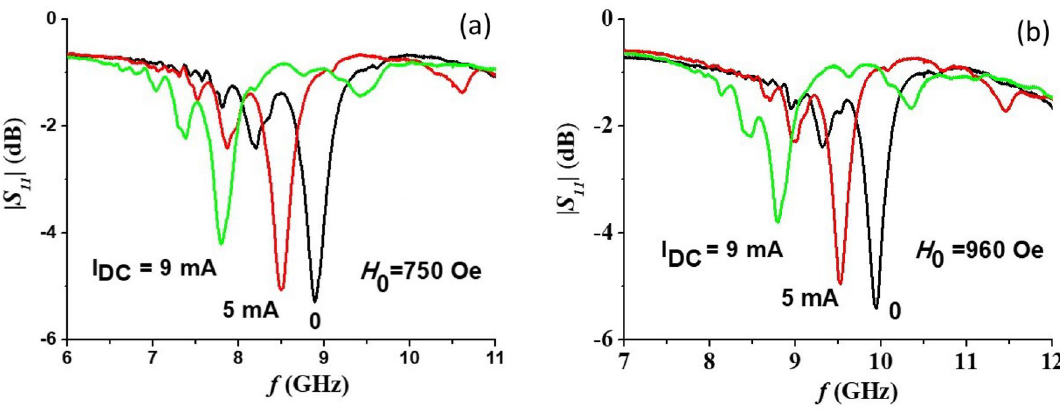
Figure 10. Return loss S 11 as a function of frequency f for a series of DC current for ( a ) H 0 = 750 Oe and ( b ) H 0 = 960